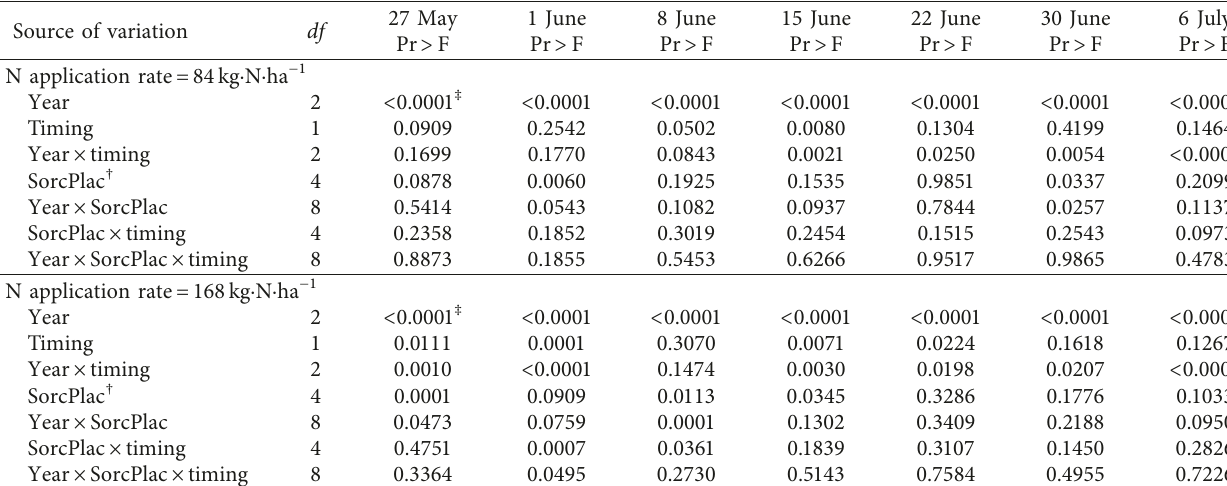
† Abbreviations: SorcPlac, source/placement. ‡ Numbers in bold represent Fisher’s protected least significant difference at P ≤ 0 . 05.